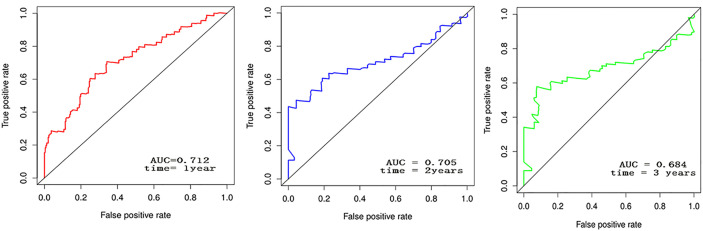
The AUC corresponding to 1, 2, and 3 years of CXCR signature using K-M plot.